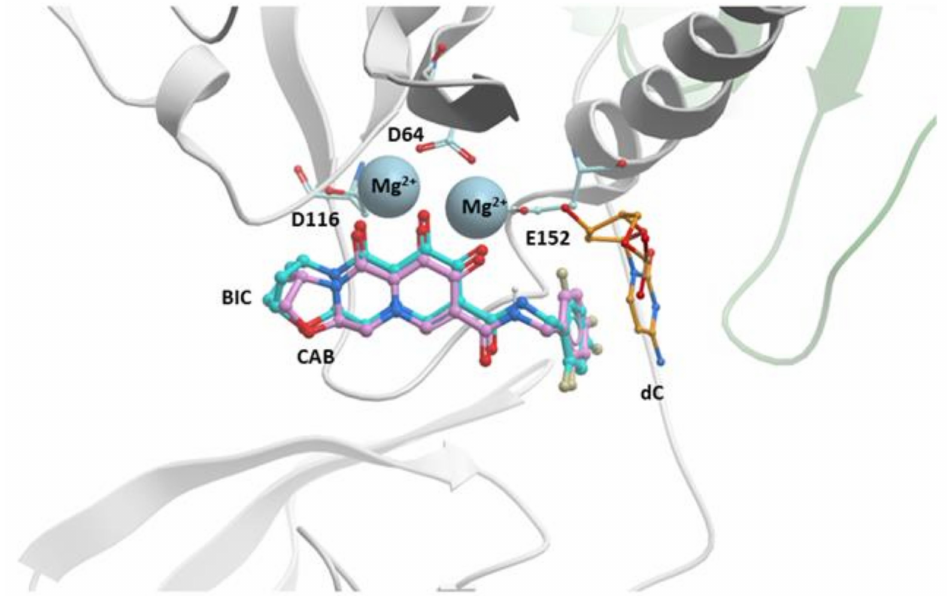
Figure 6. Modeling CAB onto the structure of BIC in the active site of the HIV-1 intasome. CAB (purple) is docked onto the structure of BIC (cyan) in the active site of the HIV-1 intasome. HIV-1 IN is shown; its catalytic residues are shown and labeled. The penultimate cytosine is shown (labeled), as are the Mg 2+ cofactors (shown in gray and labeled). The terminal adenine on the viral DNA end is omitted for